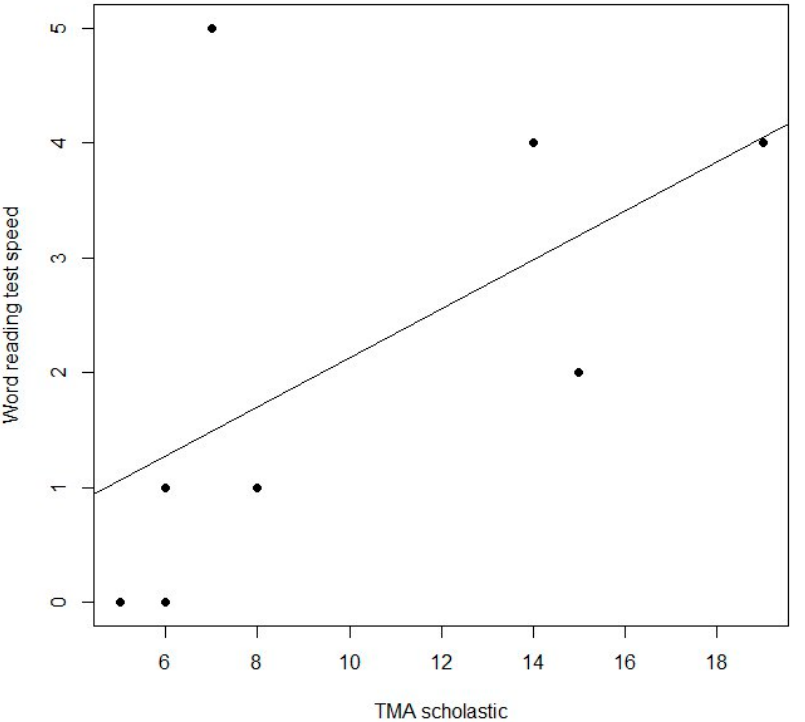
Figure 1. Correlation between scholastic TMA and word reading test speed in experimental group. The X-axis and Y-axis represent the differences in T1-T0 scores on the TMA scholastic and word reading tests, respectively.